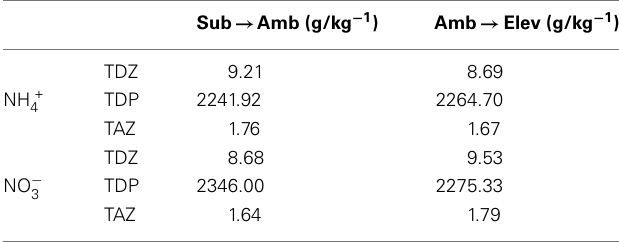
) and open (NO − ) 4 3